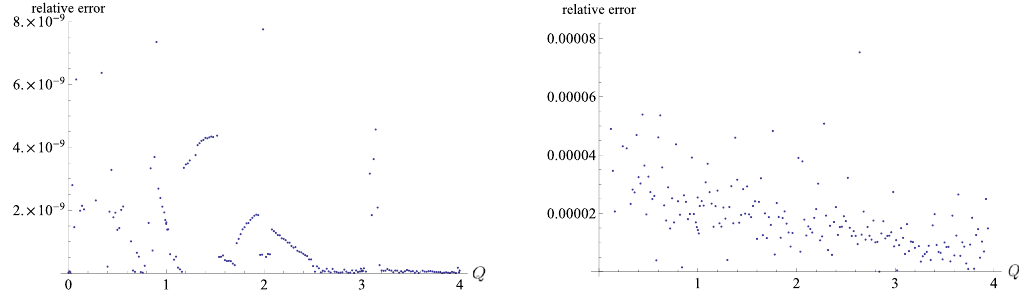
Figure 28 . The relative errors in the comparisons of the bootstrap results with the analytic expressions of A aaaa ( W 0 , − 1 ) in figure 7 (left) and A aaaa ( W 4 , 1 ) in figure 25 (right). These give a A aaaa ( W 2 , 1 ) measure of the accuracy in the bootstrapped